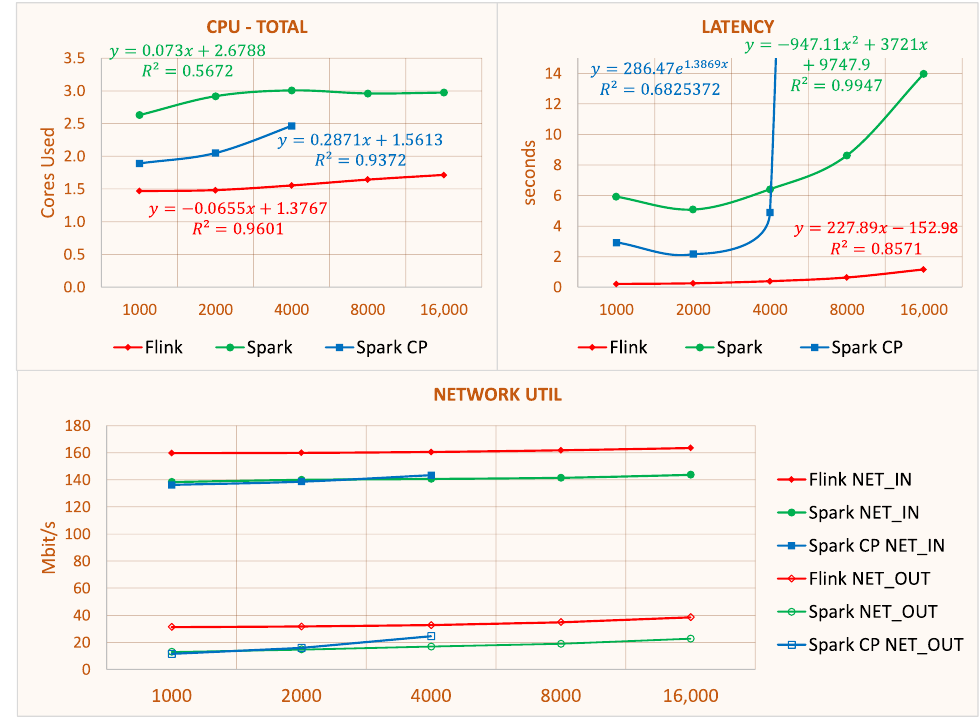
Figure 15. CPU consumption when scaling campaigns 1k–16k—summary. Total : For all SPEs, the efficiency decreases mainly due to the cost increase of the Windowing+Redissink task. Flink’s CPU utilization and latency both increase with the number of campaign_ids , whereas, for Spark STR, it appears that the total CPU costs cap at about 3.0 cores. However, looking at the latency, we see that the latency jumps up to 14 s. Hence, the CPU savings are bought at the cost of larger micro-batch sizes. Spark CP was not able to reliably scale beyond 4000 campaign_ids , probably due to the steep incline of the Windowing+Sink task. Stalling : As displayed in Figure 16, both the number of retired and stalled cycles increase with the number of campaign_ids . The IPC of all SPEs drops, partially due to an increase in context switches and branch